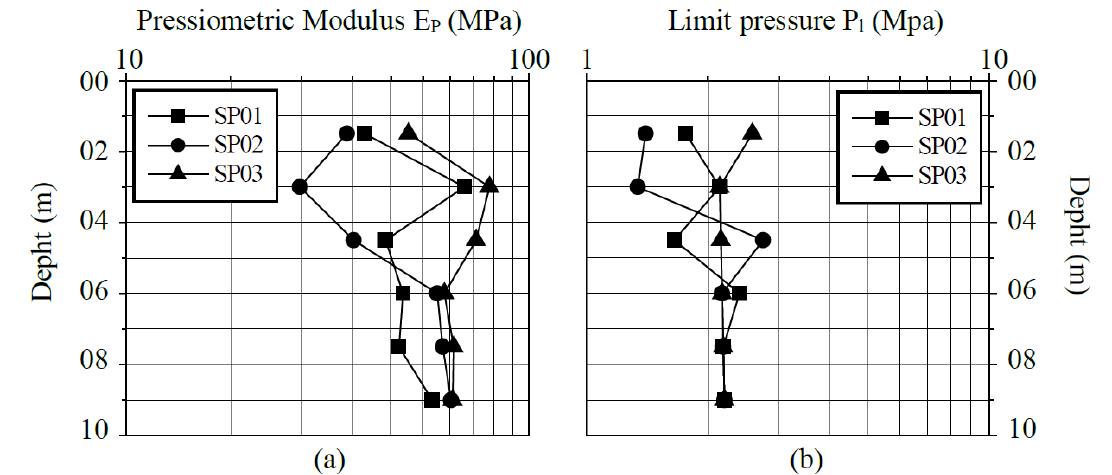
Figure 5: Pressuremeter test